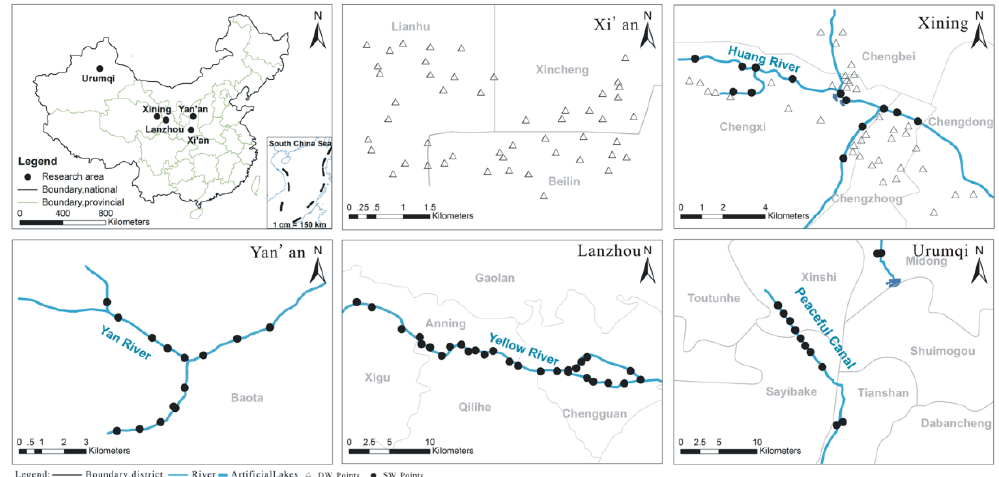
Figure 1. The study area and sampling locations map.